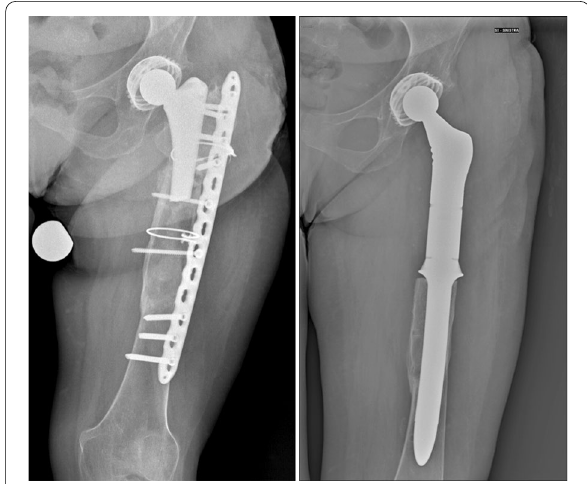
Fig. 1 Pre- and postoperative radiographies of a patient with periprosthetic and prosthesis component fracture treated first with plate and cable fixation and then, because of persistent pain and unstable fixation, with proximal femoral